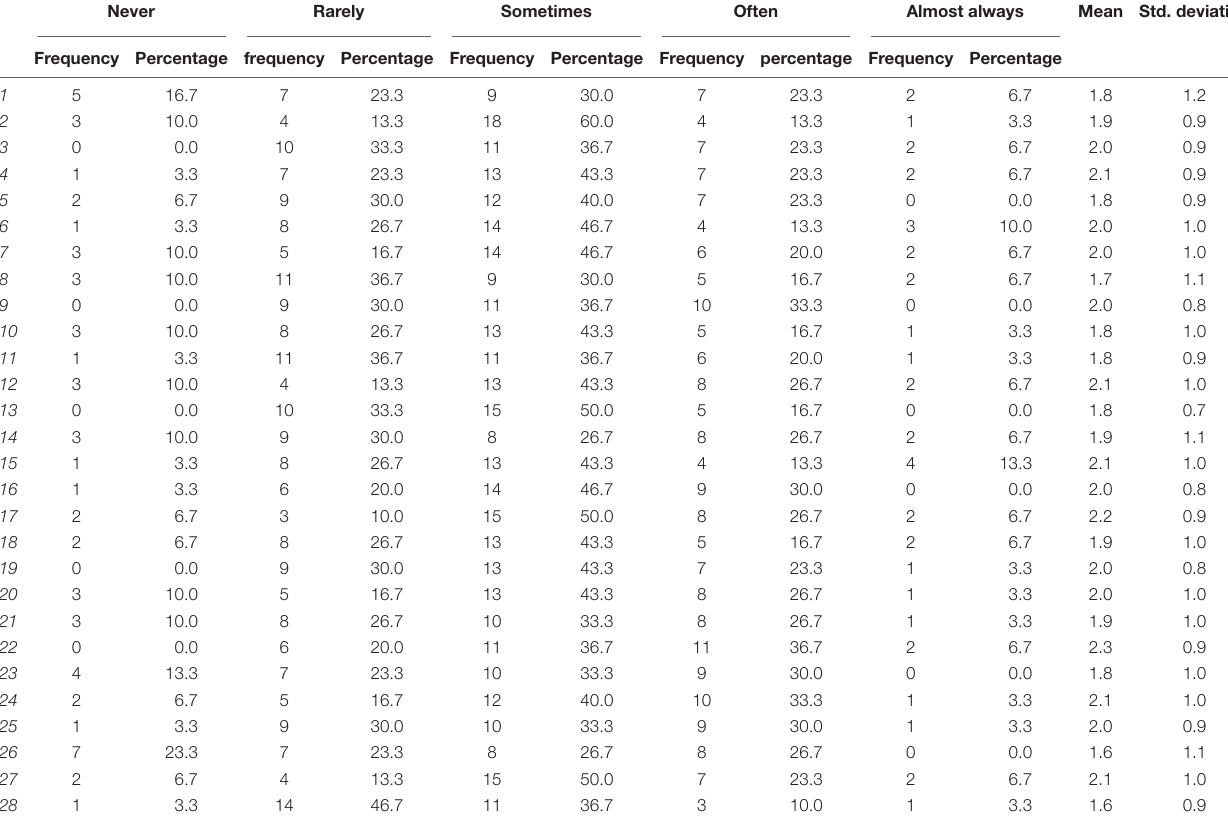
TABLE 1 | Distribution of the responses of the control group to the questionnaire before Treatment. Never Rarely Sometimes Often Almost always Mean Std.